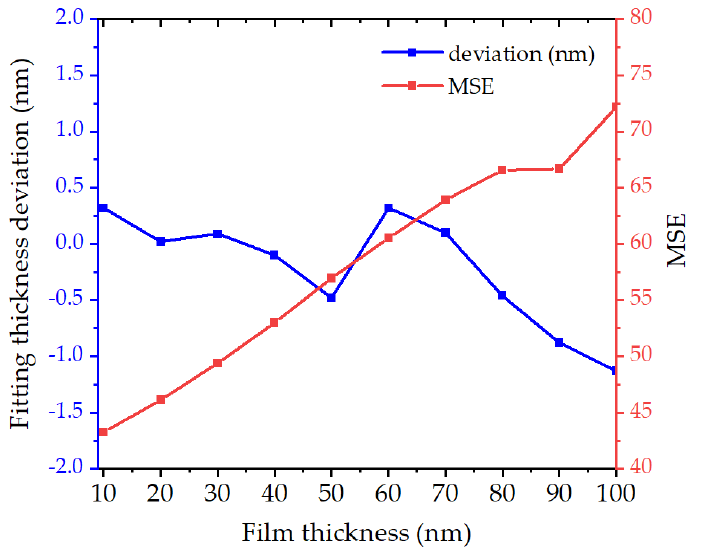
Figure 5. Fitting Thickness deviation and MSE of FDTD simulated smooth thin films of SiO 2 film with thickness of 10–100 nm on silicon substrate under the 65° incident angle.